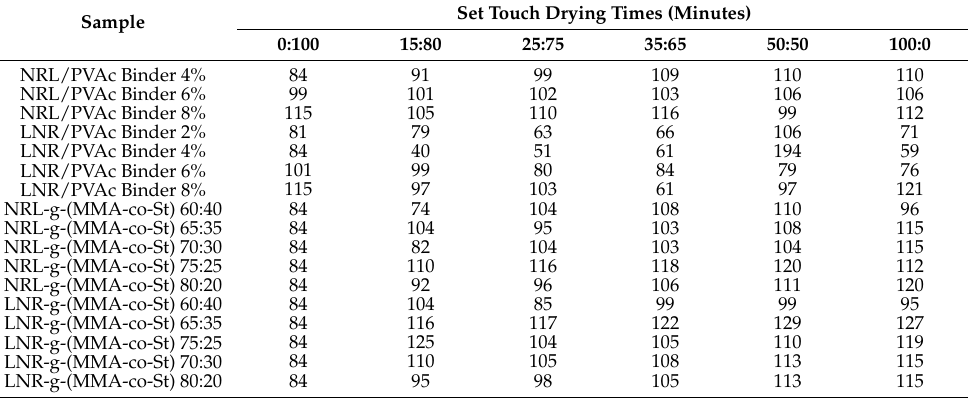
Table 3. Properties of emulsion paint touch drying time sets on various binder compositions.